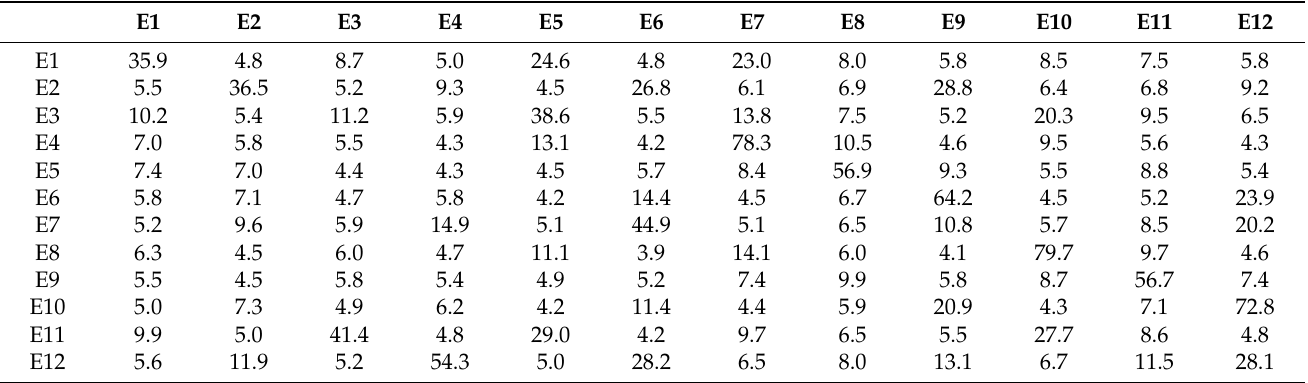
Table 4. Thermal radiation intensity ( KW/m 2 ) of element i to element j under the action of sprinkler